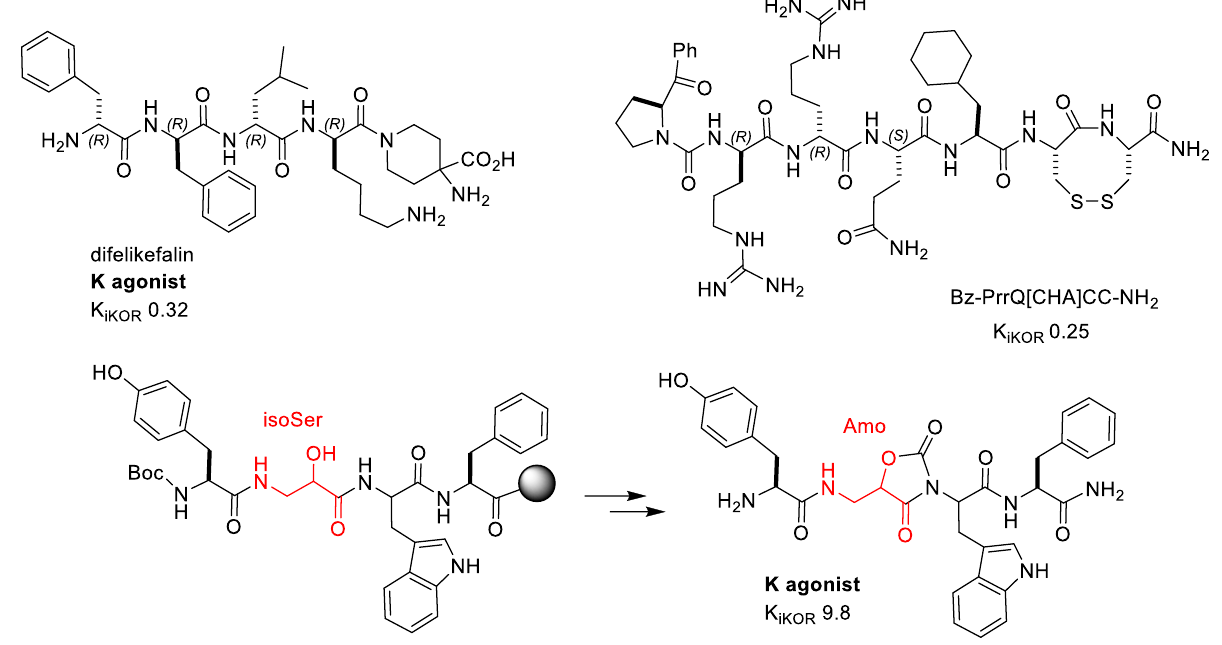
Figure 5. Peptidic and peptidomimetic KOR agonists.